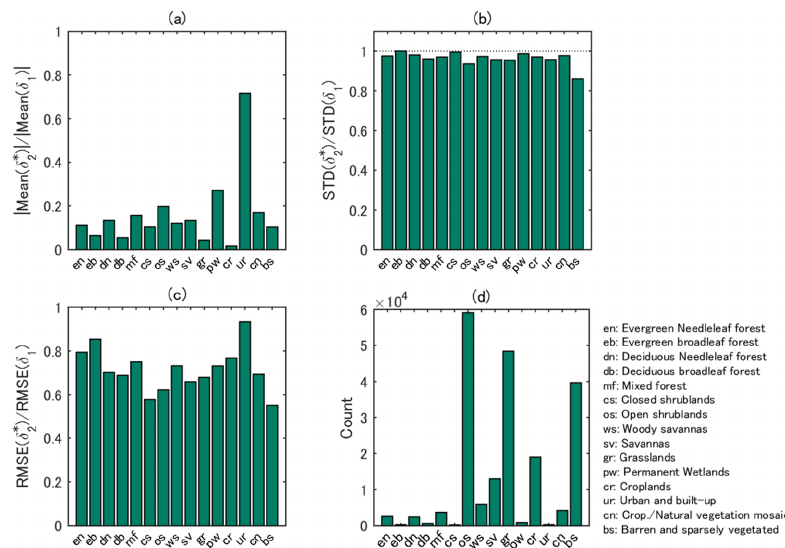
Figure 9. ( a ) Ratio of absolute mean of difference between MODIS EVI minus MODIS-compatible VIIRS EVI ( δ (cid:2870)∗ ) to that between MODIS EVI minus VIIRS EVI ( δ (cid:2869) ) for land cover-dependent data; ( b ) Ratio of STD for δ (cid:2870)∗ to that for δ (cid:2869) ; ( c ) Ratio of RMSE for δ (cid:2870)∗ to that for δ (cid:2869) ; ( d ) Frequency of land cover type distribution in data for evaluation.